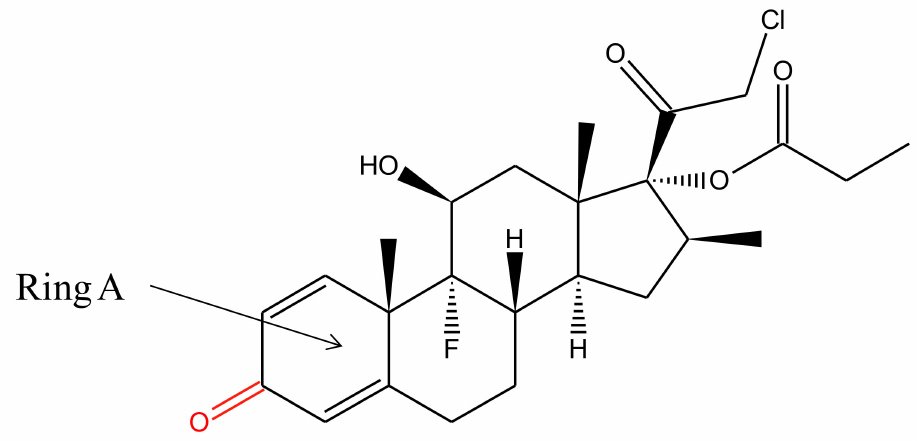
Figure 2. Chemical structure of clobetasol